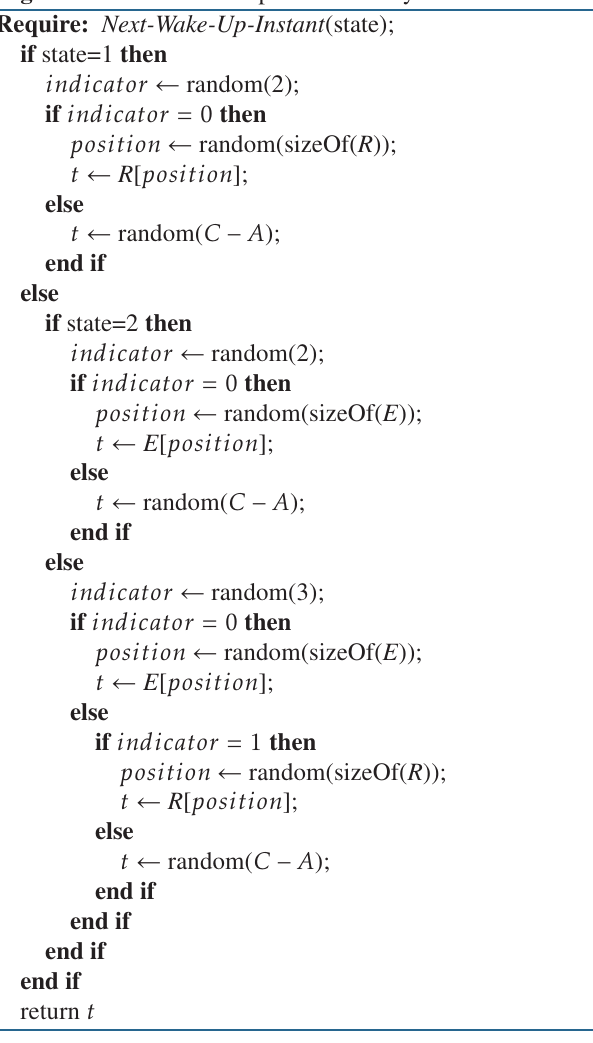
Algorithm 2 Next wake-up instant in a cycle i .